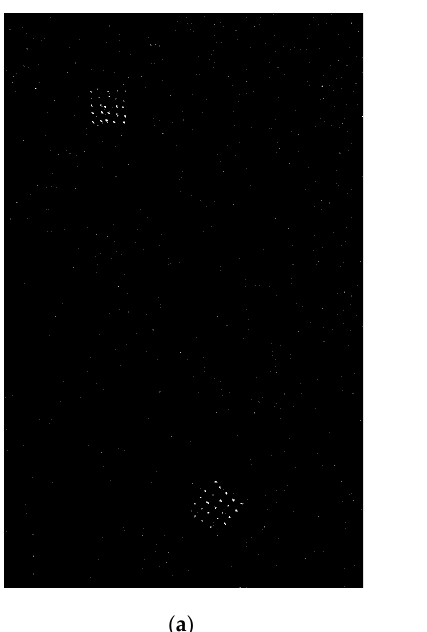
Figure 6. Constant false alarm rate (CFAR) detection results for the image pair shown in Figure 2: ( a ) detection results based on GG model; ( b ) detection results based on proposed model.